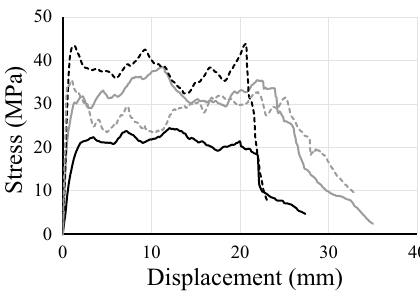
Fig. 12 Comparison of stress–displacement curves among panel types. The black solid curve is the stress–displacement curve for PW-s, black dotted curve for PB, gray solid curve for OSB-s, and gray dotted curve for HB. The other parameters were as follows: d ph 1; dowel position A = =